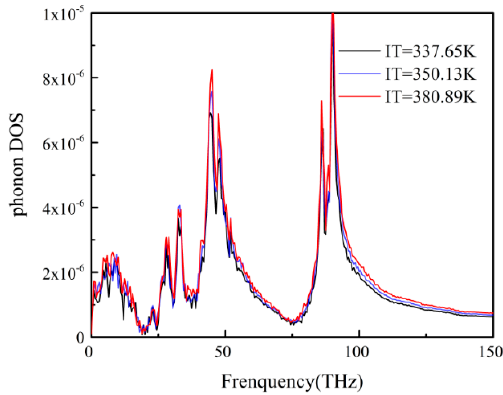
Figure 4. The phonon DOS of PP atoms at different temperatures.